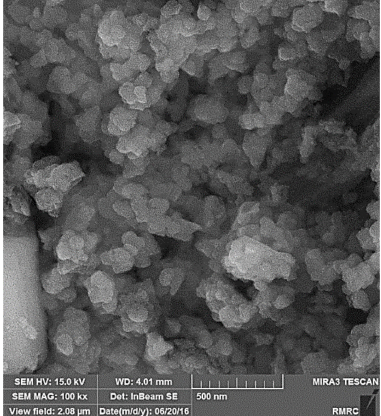
Figure 5. The field emission scanning electron microscope (FESEM) image from amorphous SiO 2 Nanoparticle